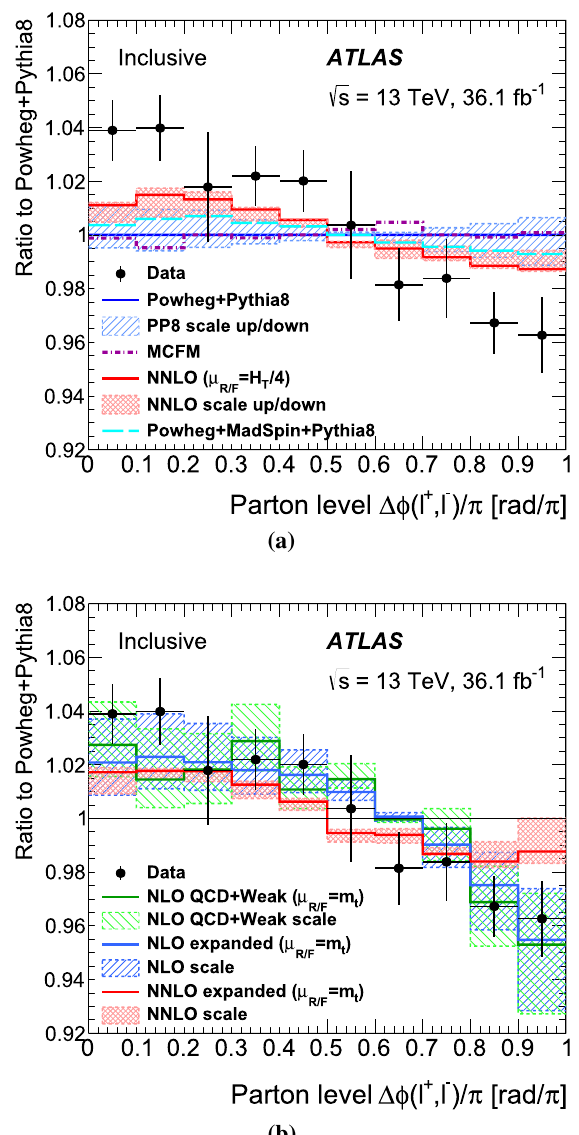
Fig. 14 Comparison of the unfolded (cid:3)φ distribution with theoretical predictions for the inclusive selection: ratio as compared with Powheg + Pythia 8 for a NLO generators and NNLO fixed-order predictions, b NLO and NNLO theoretical predictions expanded in the normalised cross-section ratio. Each prediction is discussed in the